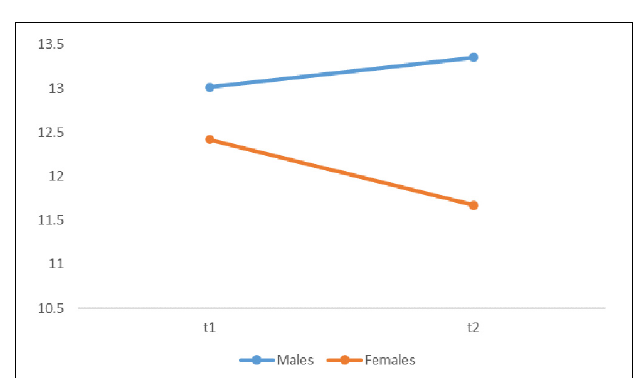
FIGURE 2 | Gender differences in perceived social support from